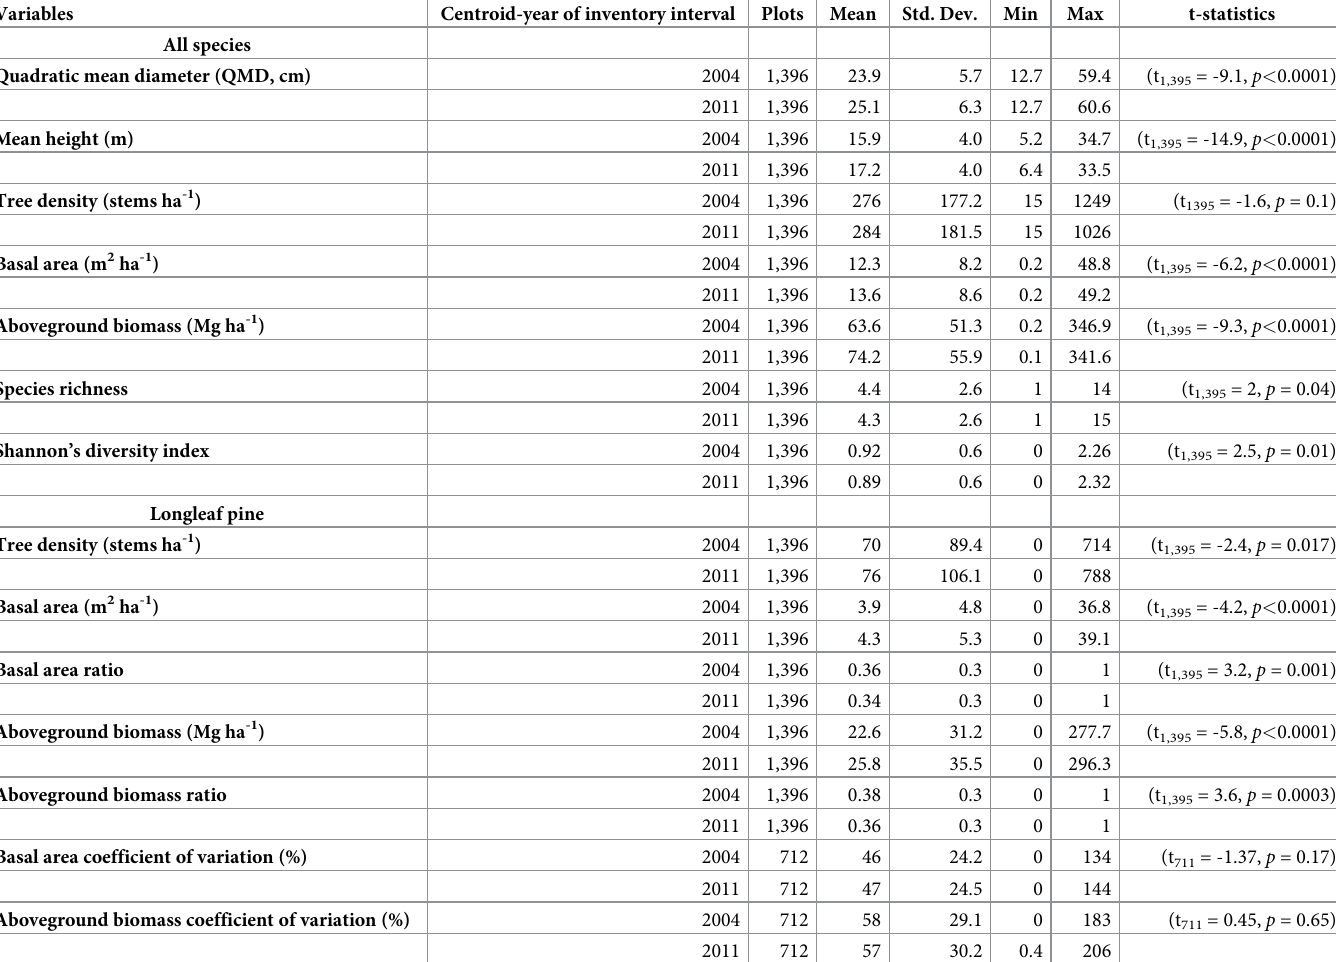
Table 3. Structural changes of all species and longleaf pine across the plots by 2004 and 2011. Where 2004 and 2011 are the centroid-year of first (1997–2010) and last (2003–2018) inventory intervals, respectively. Each pair of variables were tested using the dependent paired-samples t-test at α = 0.05 level (N =